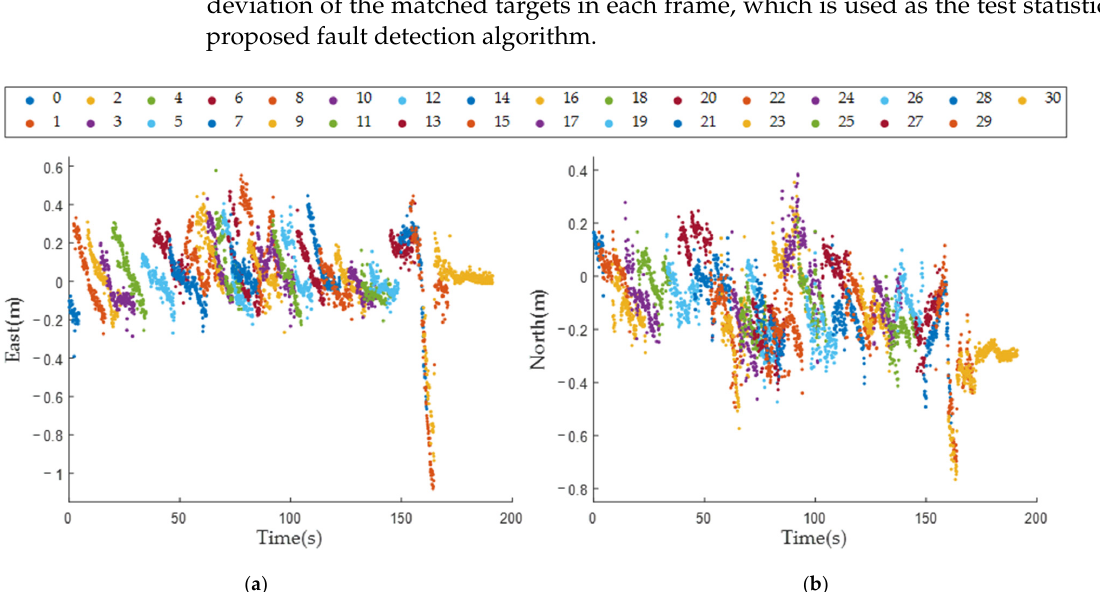
Figure 12. The mean position deviations of the matched targets in the east and north in case one. Sensitivity is an important fault detection performance evaluation index, and the missed detection rate and false alarm rate are important integrity assessment indices. Figure 13a shows the fault detection result produced by the residual chi-square test, and Figure 13b is the result of the proposed LiDAR aided real-time fault detection algorithm. The fault detection performance of the two algorithms is compared in Table 2. The fault could not be detected by the residual chi-square test, while the proposed algorithm could detect the fault from 160.02th to 164.75th s. Therefore, it can be proven that the proposed algorithm has higher sensitivity. The percentages of false alarms and missed detections were re- duced by 42.67% and 31.2%, respectively, relative to those of the residual chi-square test. 0